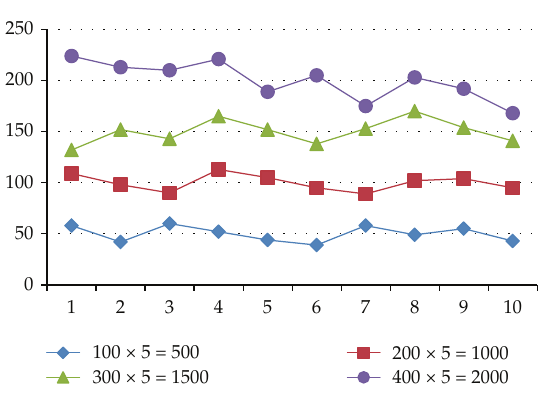
Figure 3: Files distribution over 10 device sets.